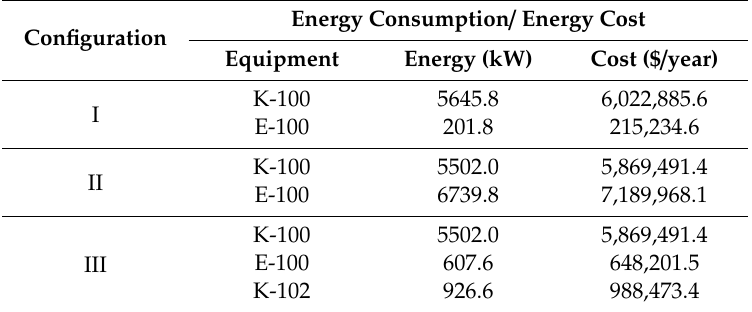
Table 4. Energy consumption and energy cost for each equipment for three